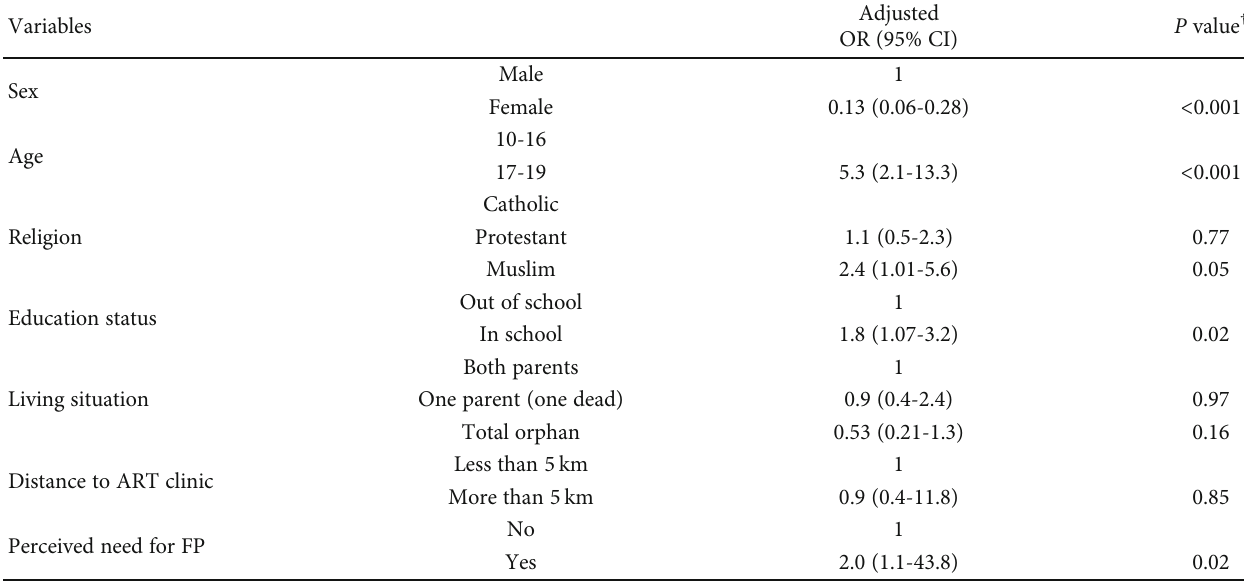
Table 3: Factors associated with family planning use among sexually active HIV perinatally infected adolescent.